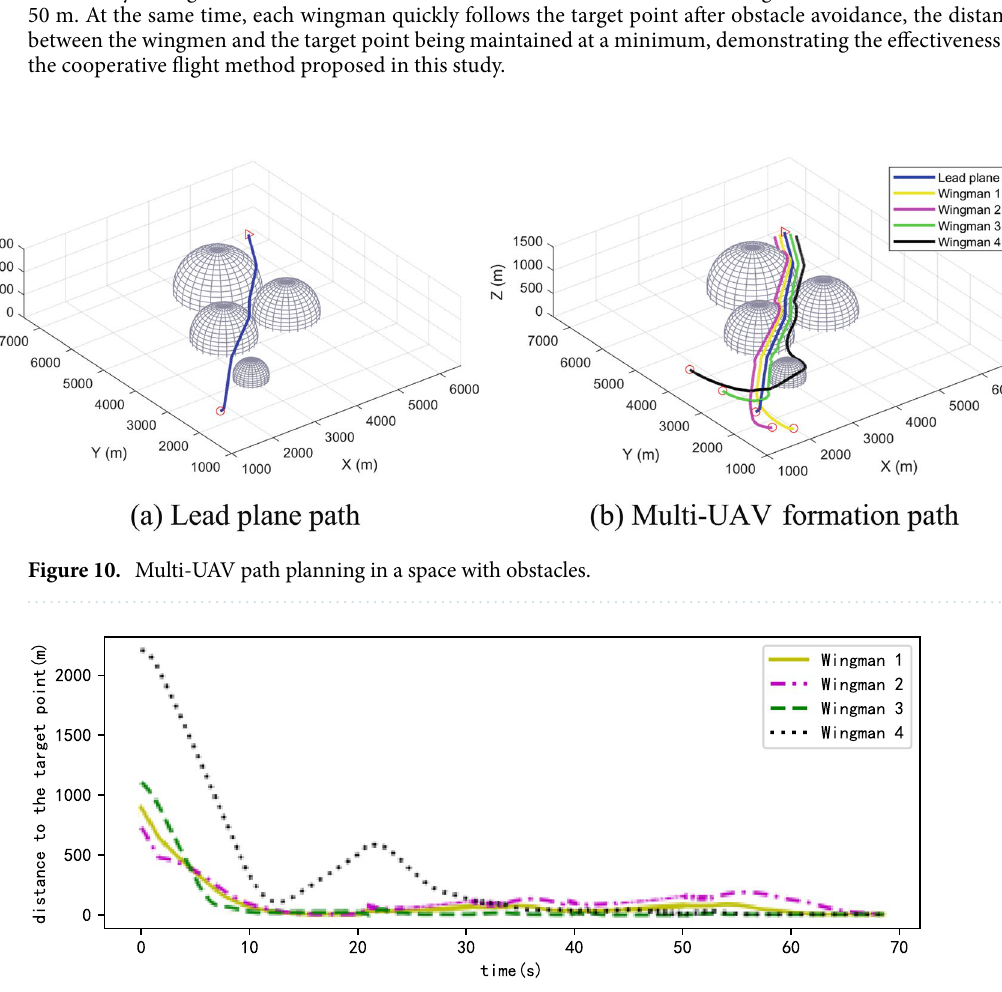
Figure 11. The situation of wingmen following the local path target points in the scene with